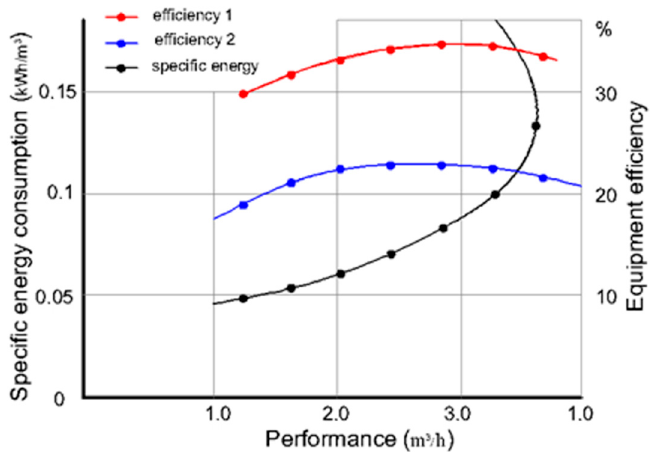
Figure 7. Regime and energy performance of the hydrocyclone plant.